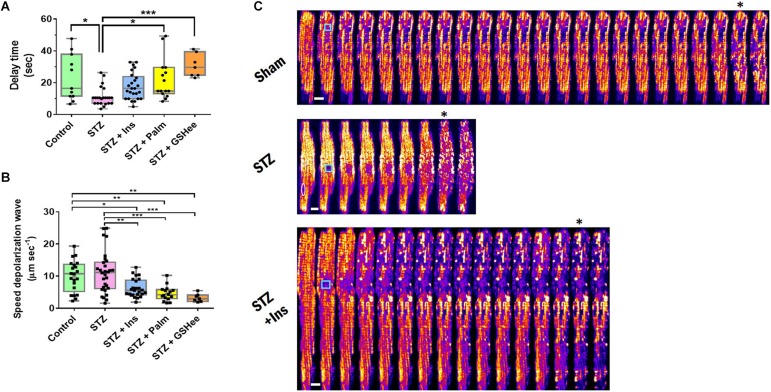
Delay time and speed of propagation of the ΔΨm depolarization wave in oscillating cardiac myocytes. Freshly isolated cardiomyocytes in Tyrode buffer with 10 mM glucose and 1 mM Ca2+ were loaded with TMRM, incubated in the presence of different substrates, and imaged (see Table 1 footnote and section “Materials and Methods”). Depicted are (A) delay time (in seconds) before depolarization of the mitochondrial network (≥50% mitochondria) elicited by a laser-flash, and (B) speed of propagation of the depolarization wave (in μm/s), exhibited by cardiomyocytes from Sham control, STZ, STZ + Ins, STZ + Palm (STZ preincubated with 0.4 mM palmitate in the presence of 10 mM glucose) and STZ + GSHee (STZ preincubated with 4 mM glutathione ethyl ester in the presence of 10 mM glucose). Sample size: (A) Control (Sham), n = 11, STZ, n = 23 and STZ + Ins, n = 25 correspond to 8 experiments/hearts for each group; STZ + Palm, n = 15 and STZ + GSHee, n = 7 were obtained from four experiments/hearts for each group. (B) Control (Sham), n = 19, STZ, n = 28, and STZ + Ins, n = 26, correspond to eight experiments/hearts for each group; STZ + Palm, n = 16 and STZ + GSHee, n = 7 were obtained from four experiments/hearts for each group. (C) Montage of representative examples of Sham, STZ, and STZ + Ins cardiomyocytes from guinea pig heart, showing fast (STZ) or slower (Sham, STZ + Ins) ΔΨm depolarization propagation after a laser flash (cyan square). In the STZ montage, the white oval delineates the nucleus position. The white bar is equivalent to ∼10 μm. The speed of propagation of depolarization was calculated considering a time resolution of 1.644 s, which corresponds to the acquisition time of each frame (see the section “Materials and Methods” for further details). Significance levels: ∗p < 0.05; ∗∗p < 0.01; ∗∗∗p < 0.001.